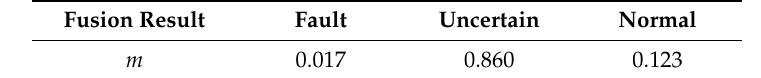
Table 4. The fusion result.